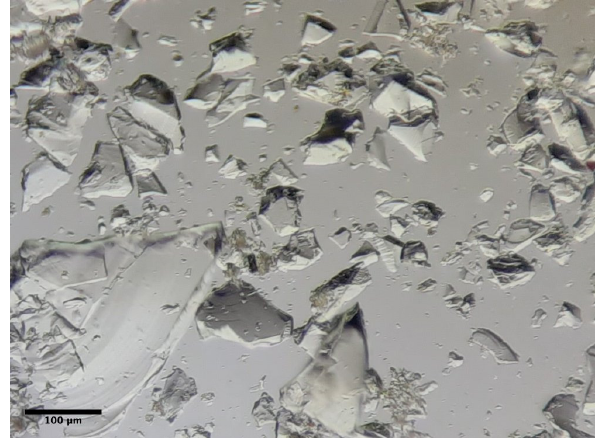
Figure 1. Crushed soda-lime bottles glass (10× magnification; Ф < 500 µm).